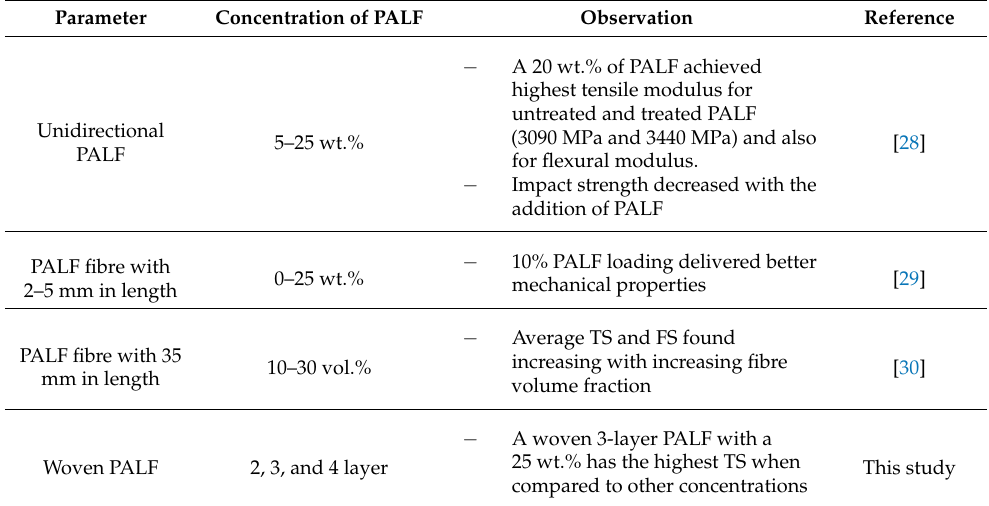
Table 4. Comparison of mechanical properties of PALF-reinforced epoxy composite with different